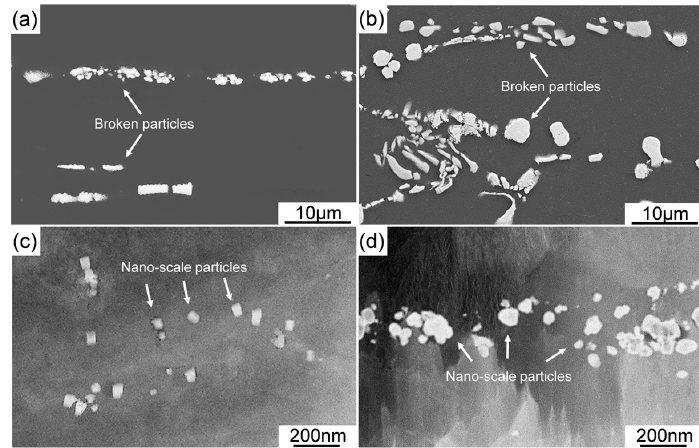
Figure 6. SEM images of the as-extruded alloys: ( a ) Mg-11Li, ( b ) Mg-11Li-4Y-2Er-2Zn, and ( c ) Mg-11Li-8Y-4Er-4Zn.